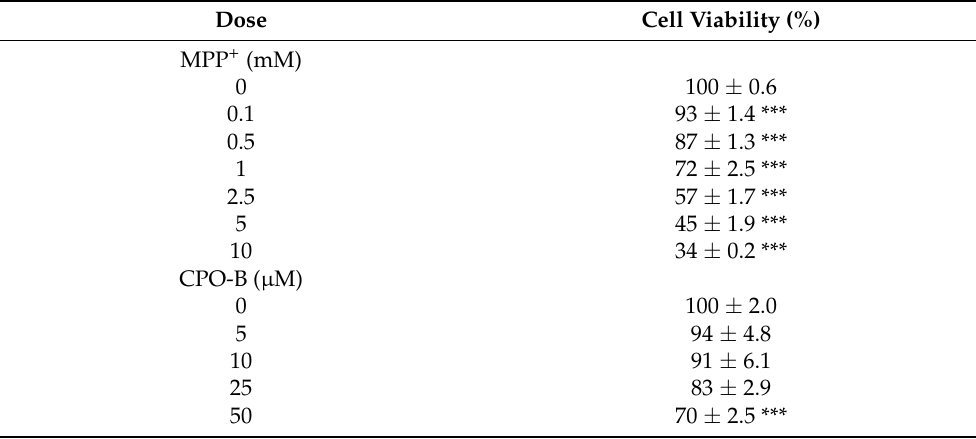
Table 1. The cytotoxic effects of MPP + ( n = 3) and CPO-B ( n = 6) on SHSY-5Y cells by MTS